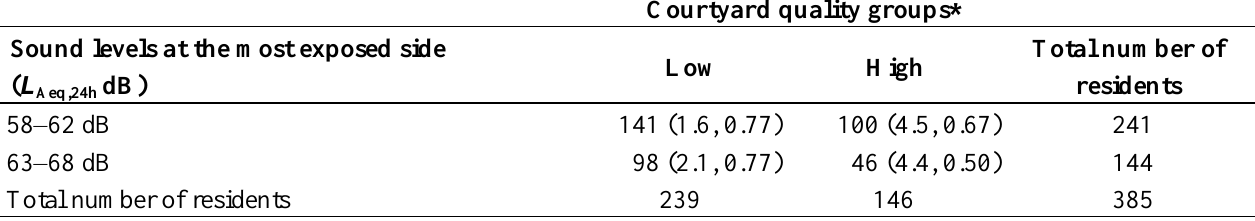
Table 2. Distribution of residents (frequency) in two courtyard quality groups and two sound level